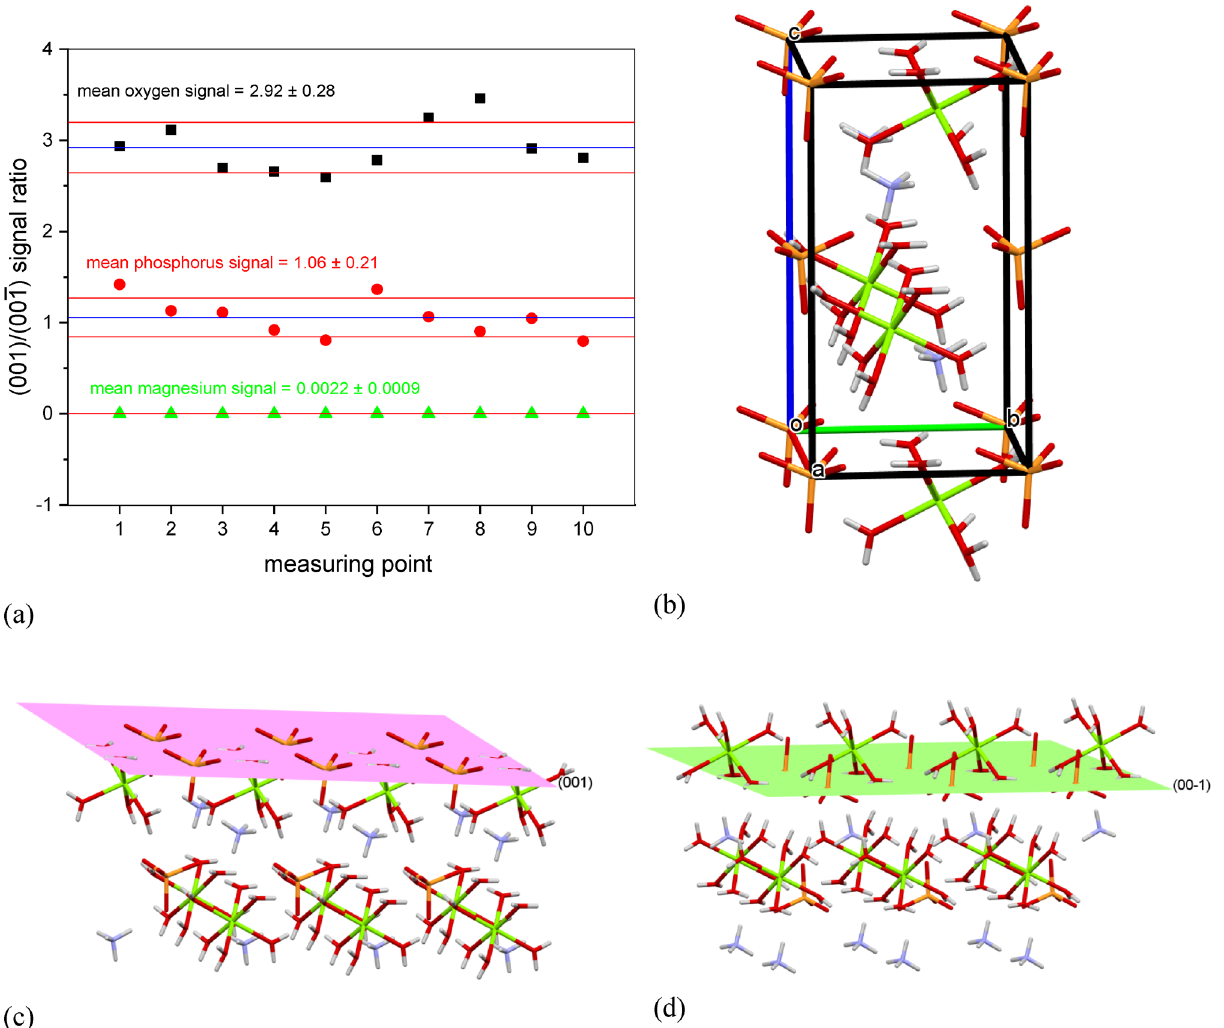
Figure 2. ( a ) ratio of the intensities of the measured signals for oxygen, phosphorus, and magnesium for surface (001) relative to the surface (00 1 ). Measurements obtained using the SIMS technique. ( b ) Arrangement of atoms in the struvite crystal unit cell. The crystal is built from PO 4 3- , NH 4 + and Mg[H 2 O] 6 2+ ; c -axis is polar. The atomic structure of surfaces ( c ) (001) and (d) (00 1 ). ( b ), ( c ) and ( d ): O, H, Mg, P and N atoms are colour coded respectively: red, whitish gray, green, orange, and purple.